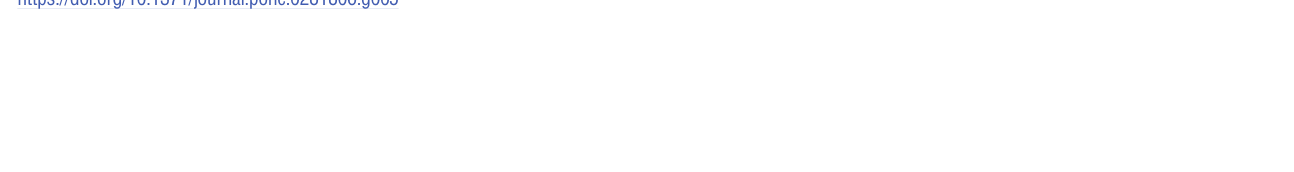
PLOS ONE | https://doi.org/10.1371/journal.pone.0281806 March 30, 2023 11 /